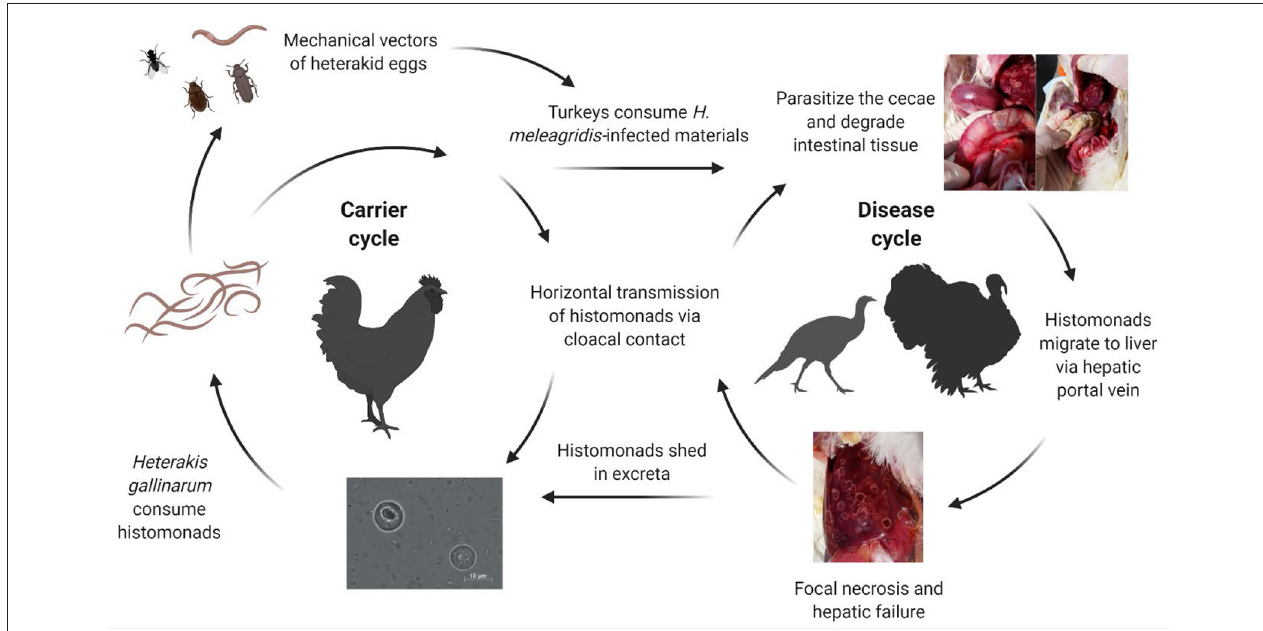
FIGURE 1 | Complex transmission of Histomonas meleagridis . Histomonads can be consumed by Heterakis gallinarum and can be subsequently incorporated into the nematode ova. Carrier birds such as chickens can harbor the cecal worms and shed infected heterakid eggs into the environment. Earthworms, flies, and other invertebrates can serve as intermediate mechanical vectors of infected heterakid ova. Turkeys may ingest infected materials such as excreta or invertebrates contaminated with the protozoa. Once inside the intestine, the histomonads will migrate to the ceca, replicating and degrading the cecal lining. Direct transmission can occur rapidly from turkey-to-turkey due to cloacal drinking and reverse peristalsis movement of materials into the vent region (Created with